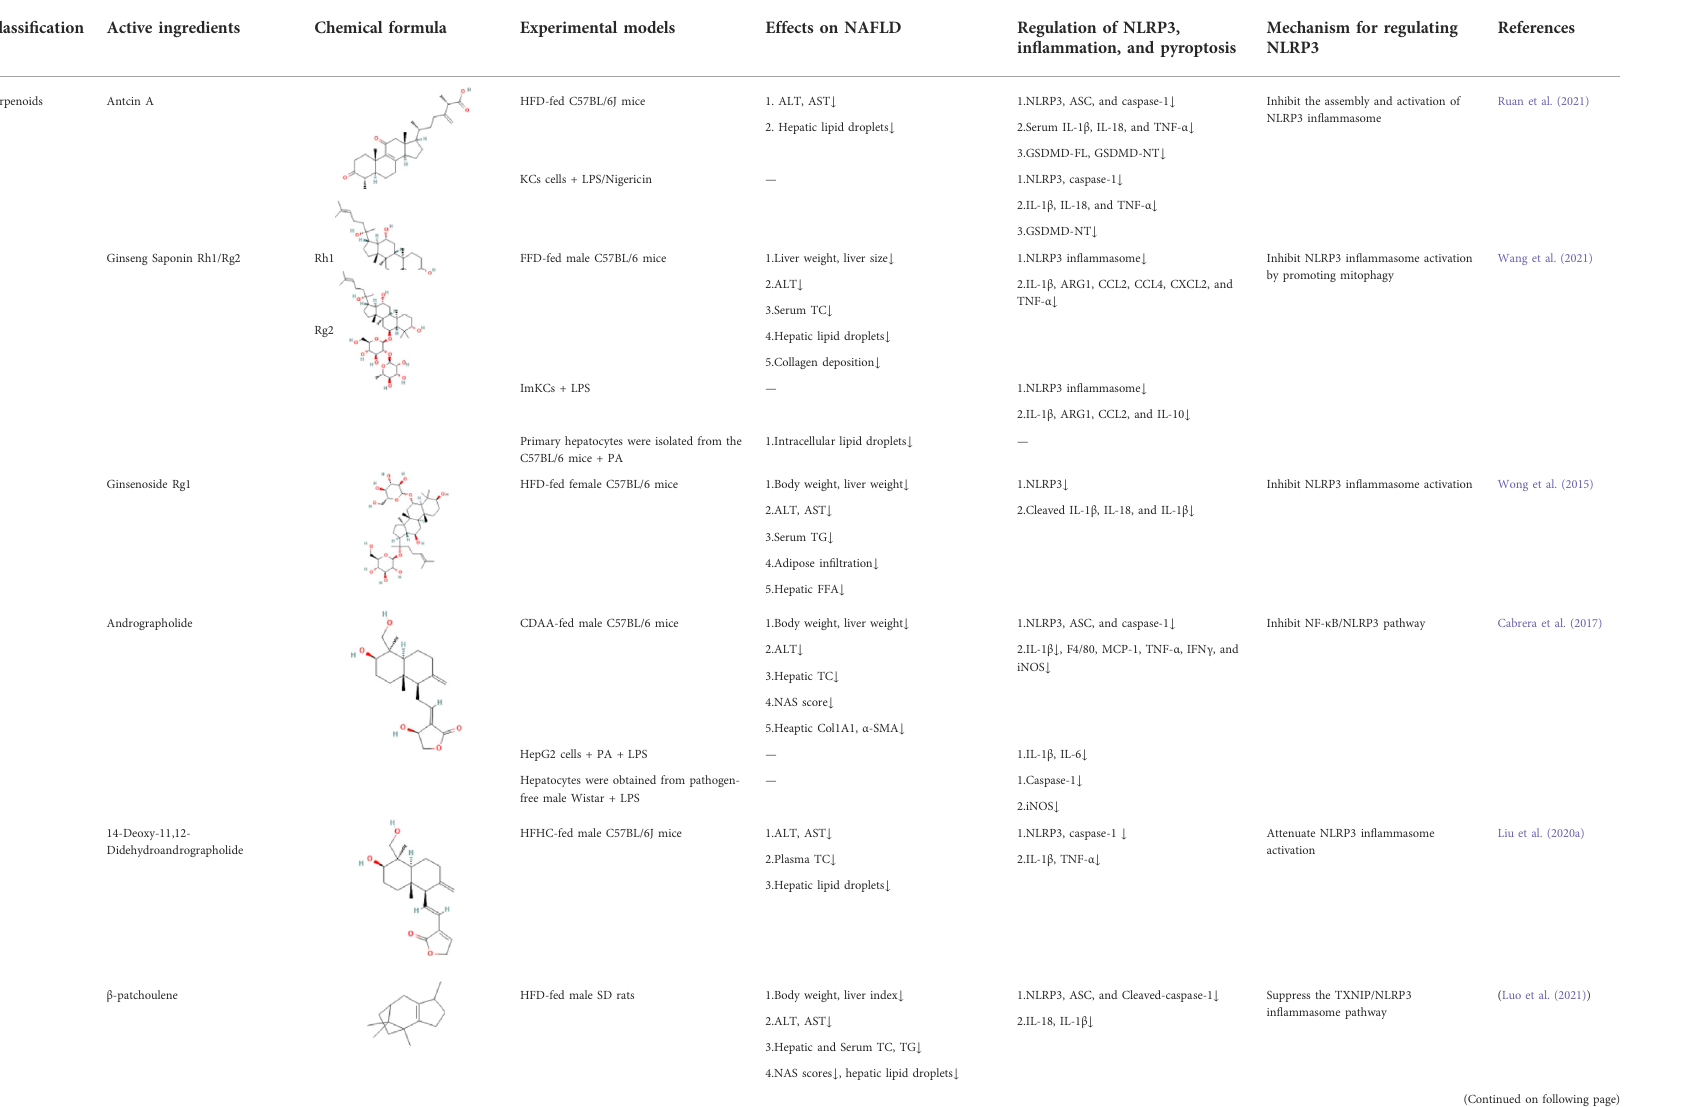
TABLE 1 Plant-derived bioactive compounds treat NAFLD by regulating NLRP3 in fl